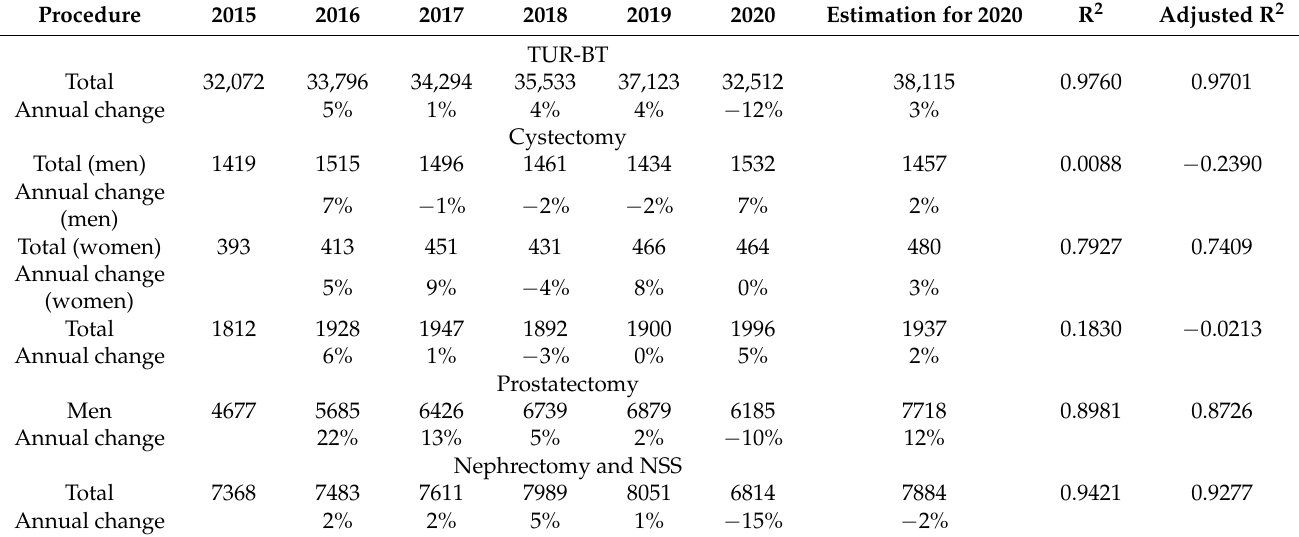
Table 4. Urological oncology procedures performed in 2015 to 2020.